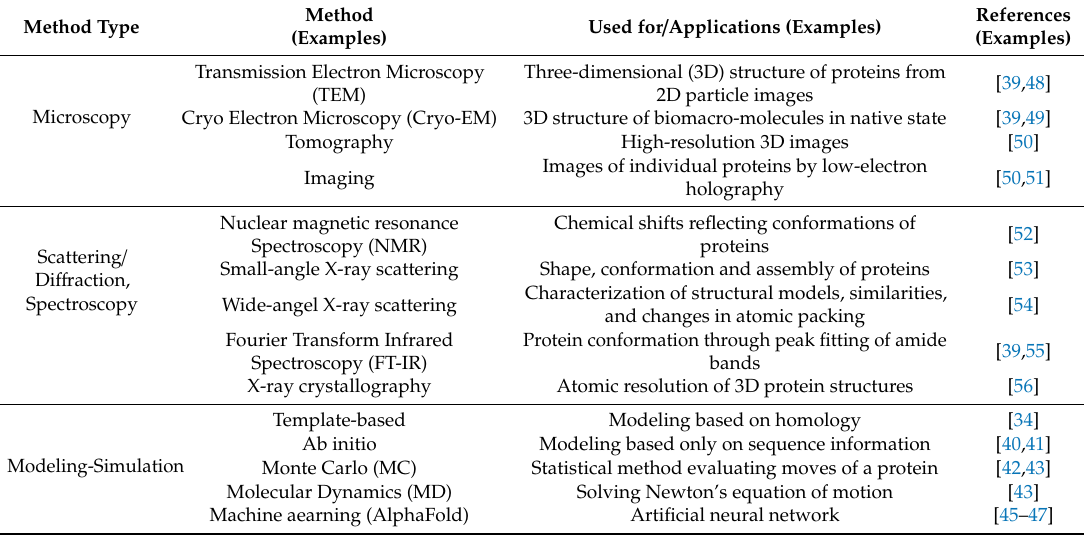
Table 3. Methods used to determine protein structures and structure-function